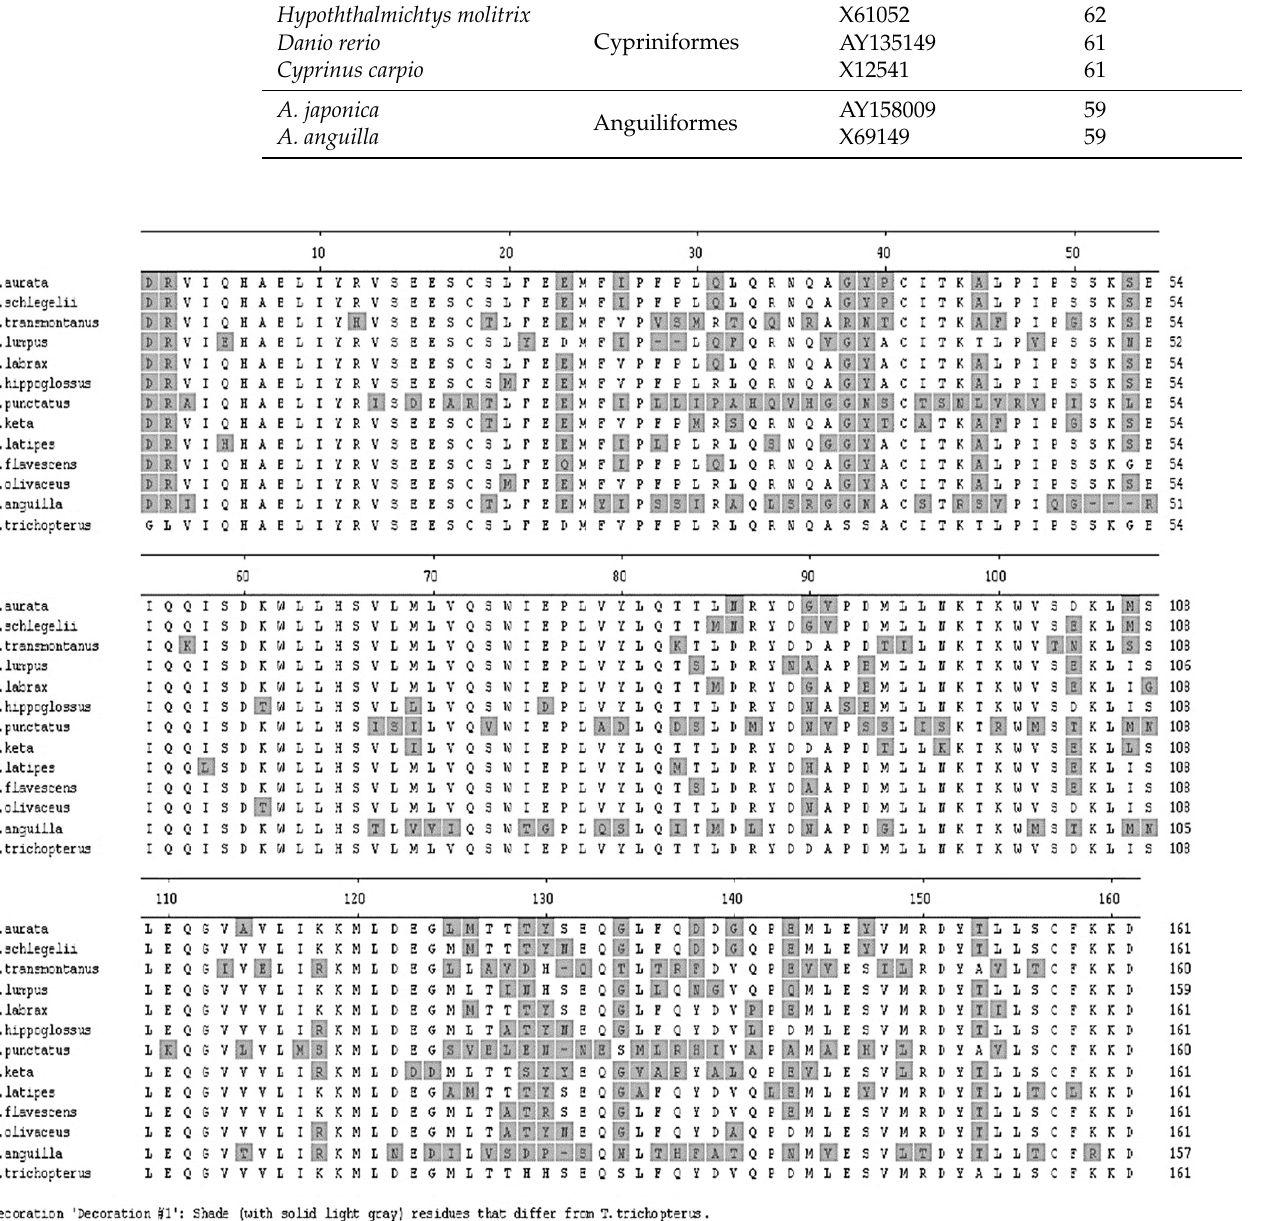
Figure 23. Phylogenetic tree showing the relationship between SL amino acid sequences from blue gourami and other fish species. The tree was generated by maximum Clustal W align- ment and the MegAlign program (DNASTAR). All sequences were obtained from NCBI Gen- Bank [44,45]. The highest degree of homology for SL was between T. trichopterus and the Per- ciform Perca flavescens and Cyclopterus lumpus . The lowest level of homology was observed with Anguilla anguilla .